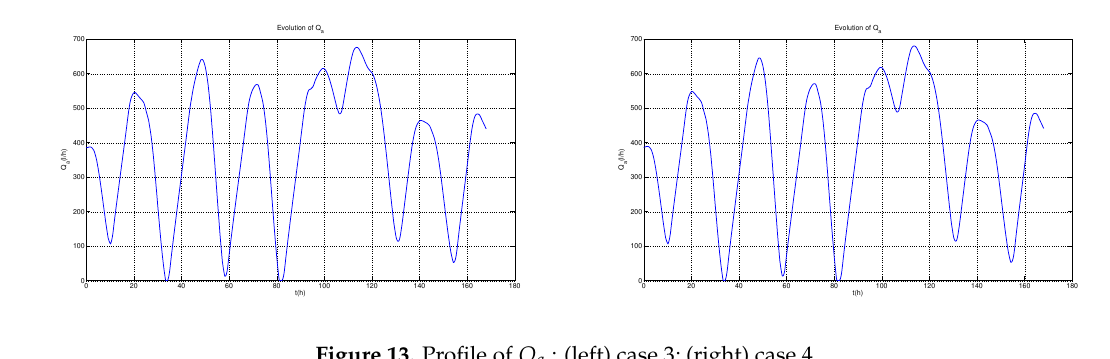
Figure 13. Profile of Q a : (left) case 3; (right) case 4.